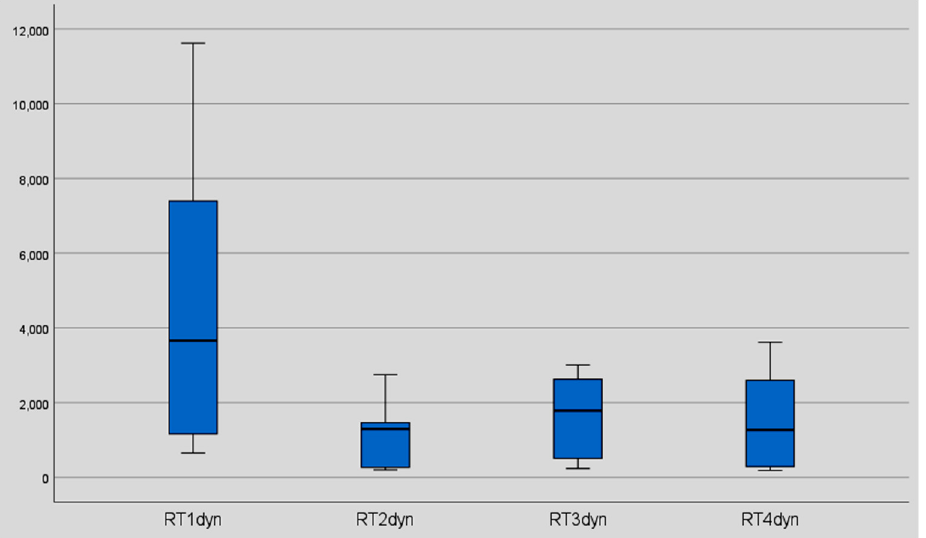
Figure 9. Reaction time of the individual threshold stereo acuities for the dynamic stereo test. The results before training (RT1dyn), after three weeks of training/ n = 1536 trials (RT2dyn), after six weeks of training/ n = 3072 trials (RT3dyn), and after six months without training (RT4dyn) of the total group.